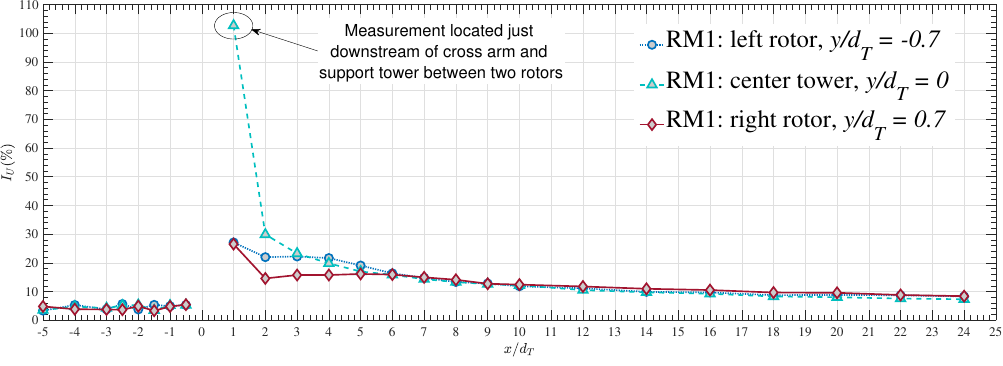
Figure 15. Hub height streamwise turbulence intensity, I u . RM1 rotors located at x / d T = 0. Measurements collected at λ ≈ 5.1 ( ω = 3.4